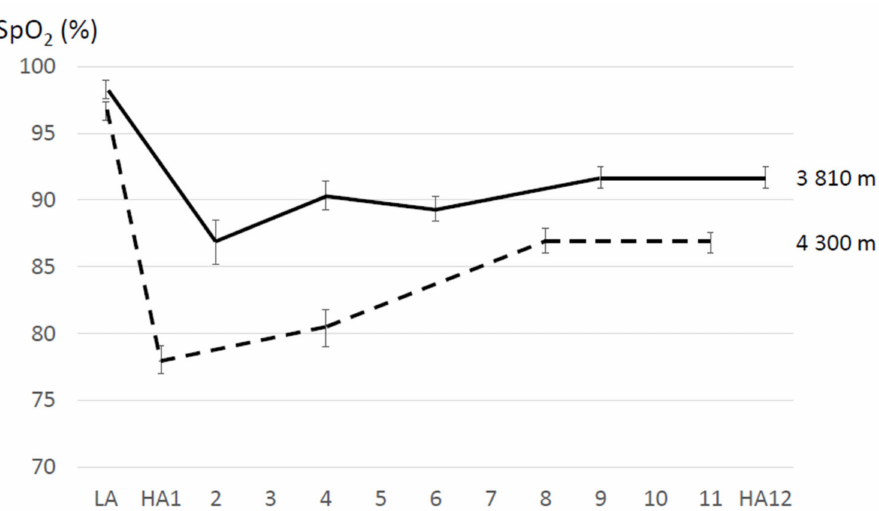
Figure 3. Example for changes of peripheral oxygen saturation (SpO 2 ) when acutely ascending from low (LA) to high altitude (HA) and during the subsequent 11- or 12-day acclimatization period based on 2 studies performed at different altitudes (3810 m and 4300 m) [65,68]. At 3800 m, resting SpO 2 was measured in a semi-supine position, with head and trunk elevated ~30 ◦ , by finger pulse oximetry (Criticare, 504-US pulse oxymeter). At 4300 m, resting SpO 2 was measured in a sitting (upright) position for a 4-min period after relaxing for 20 min, by ear oximetry (Hewlett-Packard 47201A ear oximeter, Palo Alto, CA, USA).